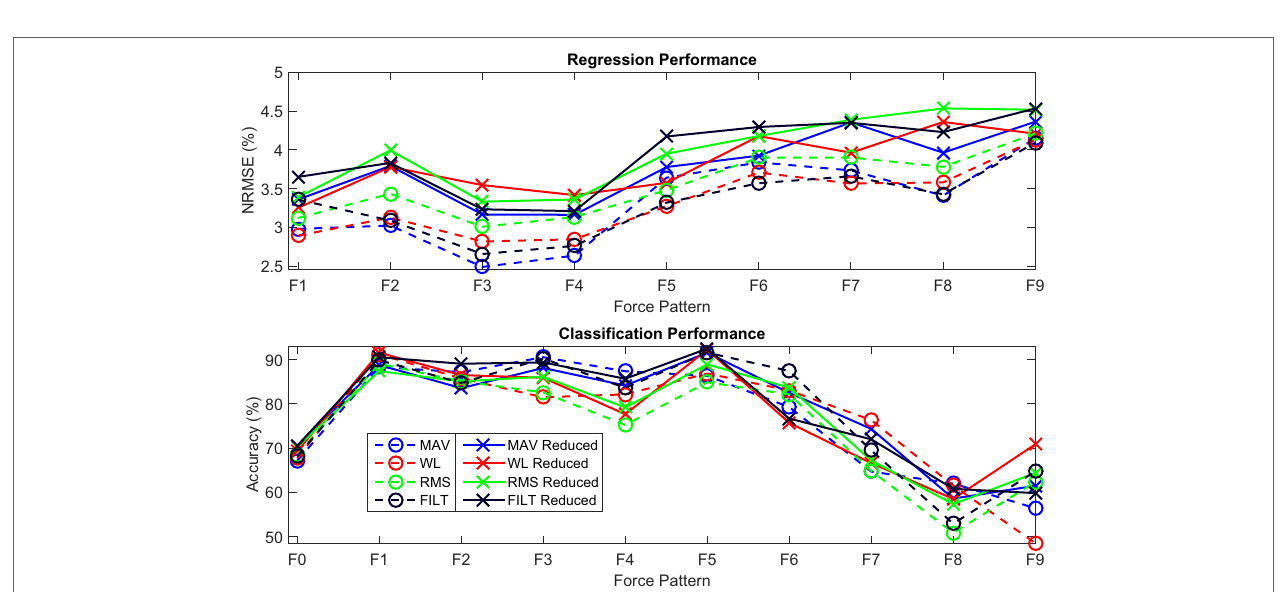
FIGURE 11 | Comparison between the models obtained using all the electrodes (dashed) and using the 8 electrodes around the forearm only (solid) for 4 FEs (MAV, WL, RMS, and FILT). Top: Average NRMSE for each force pattern for assessing the quality of the force regression. Bottom: Average classification accuracy for each force pattern, including rest (F0), for assessing the quality of